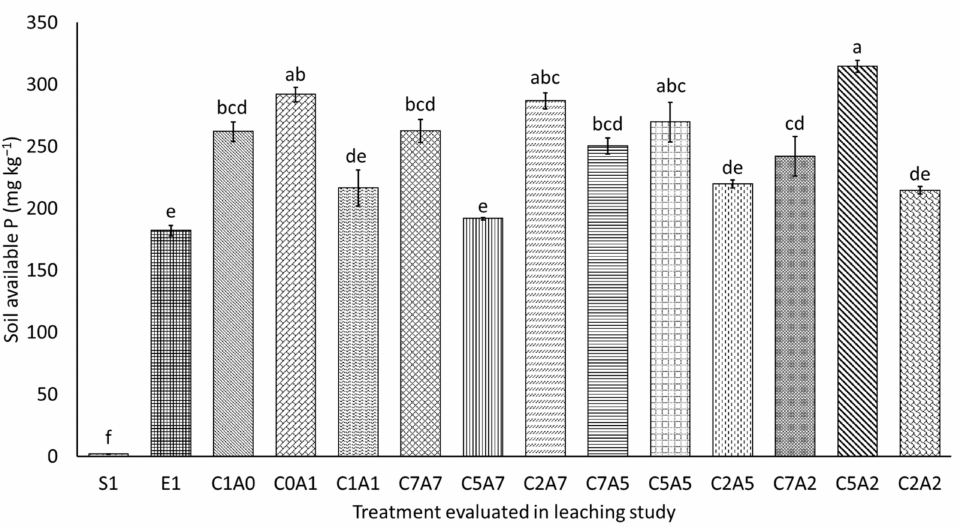
Figure 13. Treatments on soil-available phosphorus after thirty days of leaching, where S1: soil only; E1: soil with ERP only; C1: 100% charcoal; C0: 0% charcoal; C7: 75% charcoal; C5: 50% charcoal; C2: 25% charcoal; A1: 100% sago bark ash; A0: 0% sago bark ash; A7: 75% sago bark ash; A5: 50% sago bark ash; A2: 25% sago bark ash. Means with different letter(s) indicate significant differences between treatments according to Tukey’s HSD test at p ≤ 0.05, that is, a > b > c. Bars represent the mean values ±